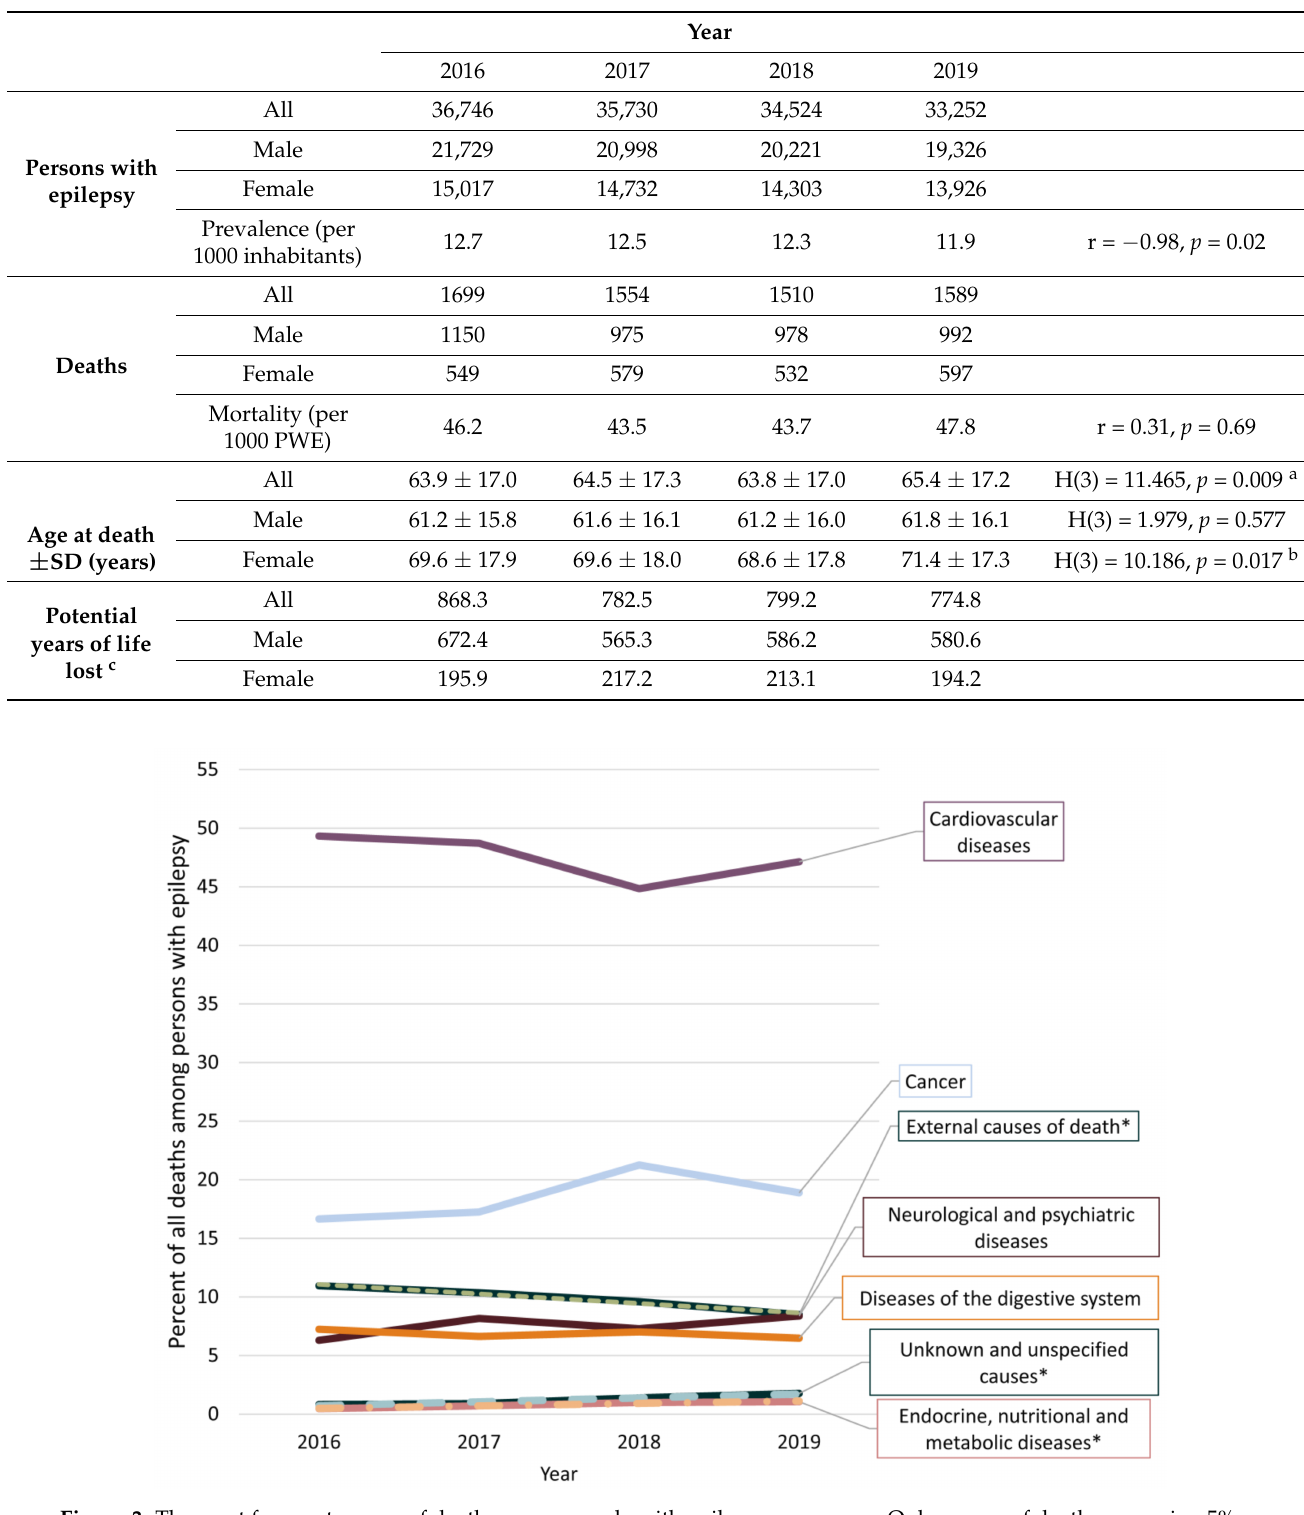
Table 2. The prevalence and mortality of persons with epilepsy included in the study. a—Bonferroni-adjusted results of post hoc comparisons for age 2016 < 2019 ( p adj = 0.020) and 2018 < 2019 ( p adj = 0.022); b—post hoc result 2018 < 2019